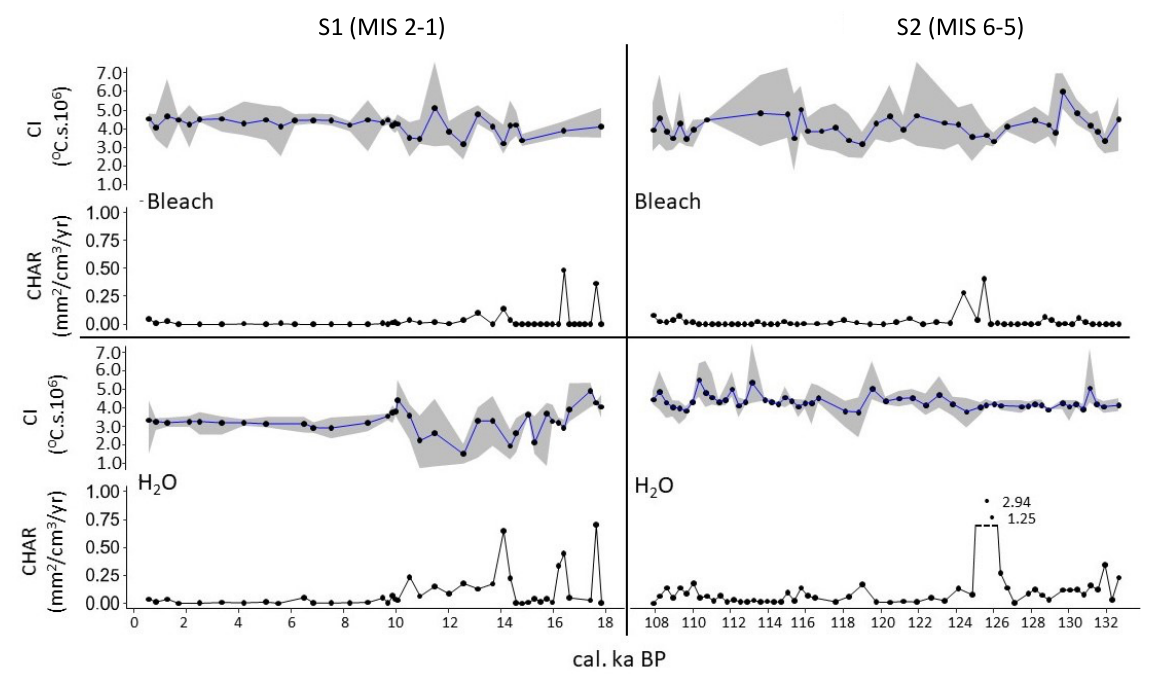
Figure 2. Comparison of charcoal area (mm 2 /cm 3 /yr) and Charring Intensity (CI) results of the LC2 core following Bleach (4% NaOCl) and H 2 O treatments. CI is presented as the mean (blue line) and minimum and maximum values (grey shading). Charcoal values were truncated at 1 mm 2 /cm 3 in the H 2 O treatment group to emphasize depths with lower accumulation values. The true values at ~125–126 cal. ka BP are marked. See Supplementary Information for CI and charcoal accumulation by depth.